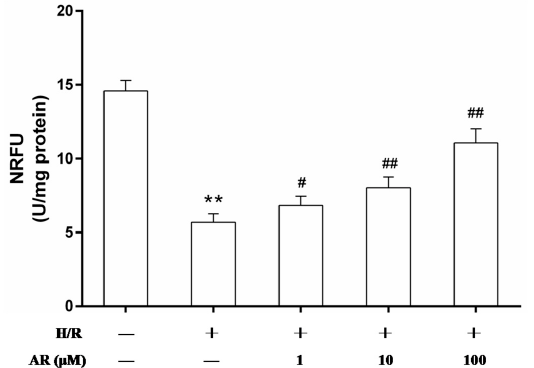
Figure 5. AR pretreatment inhibited the mPTP opening in H/R-injured H9c2